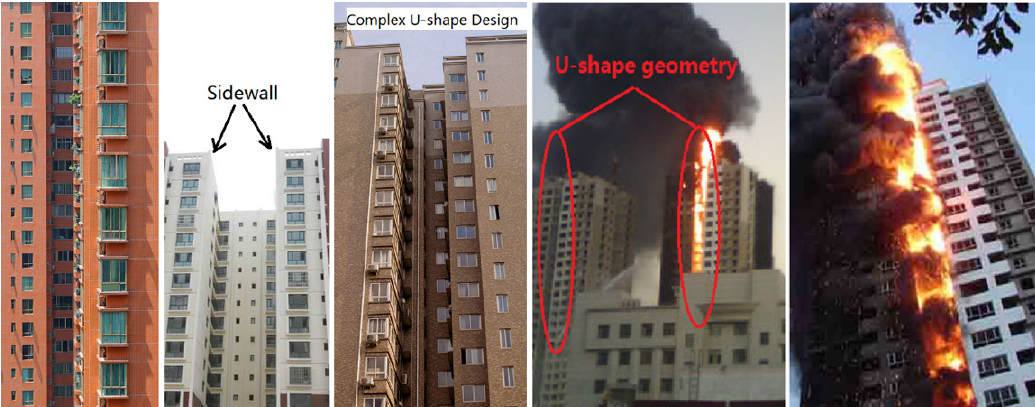
Fig. 1. Different U-shape façade wall geometry (From left: 1–3) and a fire case of such geometry (From right: 1–2. Shenhuacheng Fire, Urumqi, China, Sept. 2010)